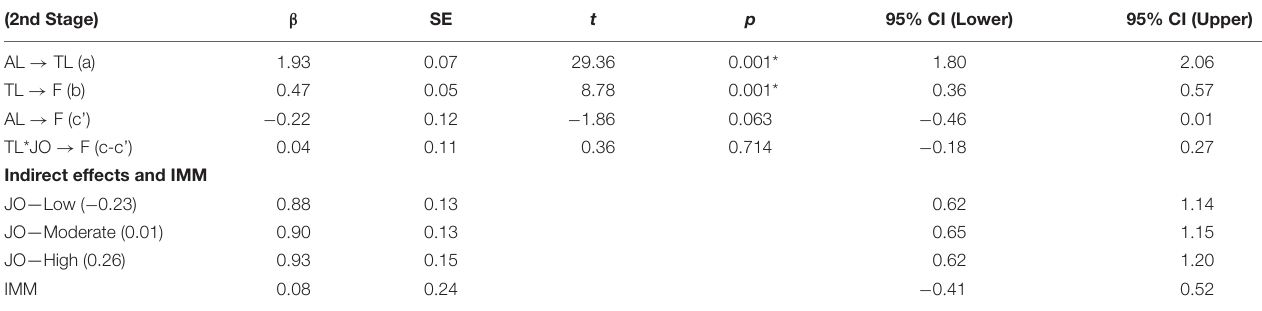
TABLE 2 | Research model: moderated mediation